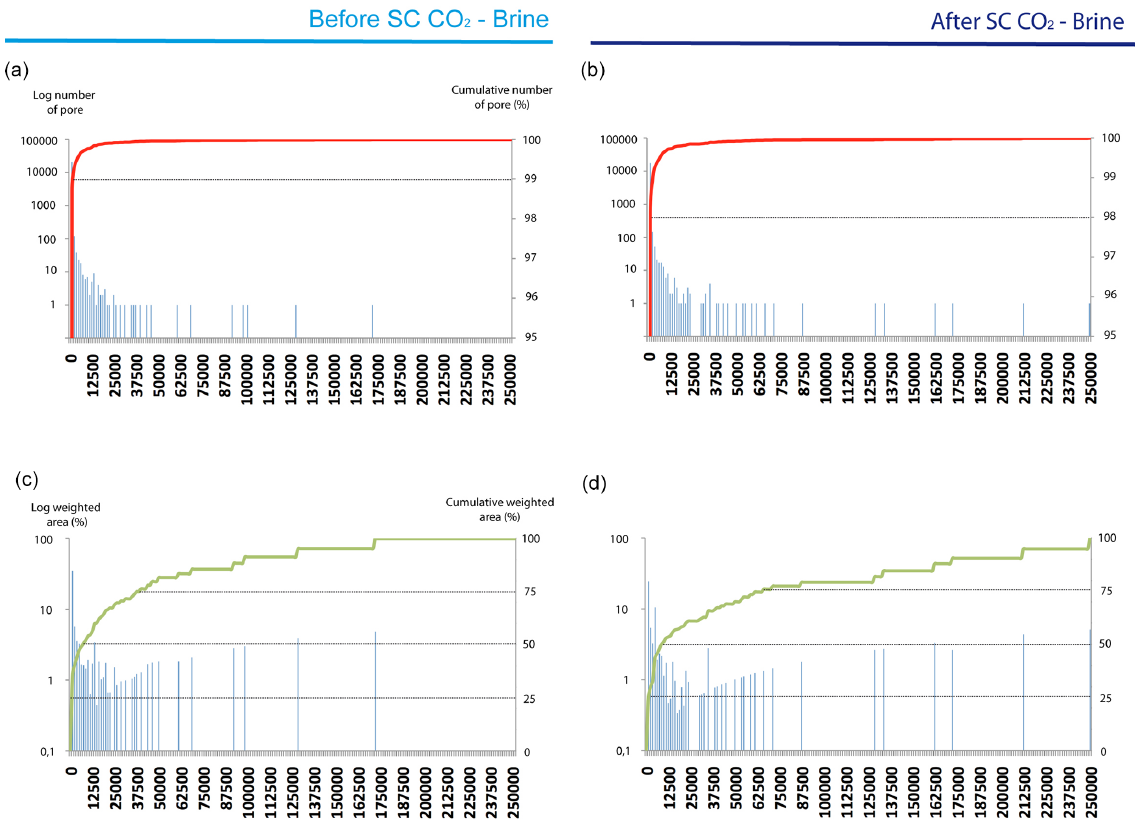
Figure 6. (a) X axis vs. left y axis: frequency diagrams of number of pores (Log scale) related to pore area classes (µm 2 ) before CO 2 injection (blue bars). X axis vs. right y axis: cumulative number of pores (%) related to pore area (µm 2 ) (red symbols). Red dashed line represents the contribution of the first class of pore area. (b) X axis vs. left y axis: frequency diagrams of weighted pore area (Log scale) related to pore area (µm 2 ) after CO 2 injection (blue bars). X axis vs. right y axis: cumulative weighted pore area (%) related to pore area classes (µm 2 ) (green symbols). Black dashed lines represent percentiles 25, 50 and 75. (c) X axis vs. left y axis: frequency diagrams of number of pores (Log scale) related to pore area (µm 2 ) before CO 2 injection (blue bars). X axis vs. right y axis: cumulative number of pores (%) related to pore area (µm 2 ) (red symbols). Red dashed line represents the contribution of the first class to pore area. (d) X vs. left y axis: frequency diagrams of weighted pore area (Log scale) related to pore area (µm 2 ) after CO 2 injection (blue bars). X axis vs. right y axis: cumulative weighted pore area (%) related to pore area classes (µm 2 ) (green symbols). Black dashed lines represent percentiles 25, 50 and 75. Minimum pore size considered in the study is >9 µm 2